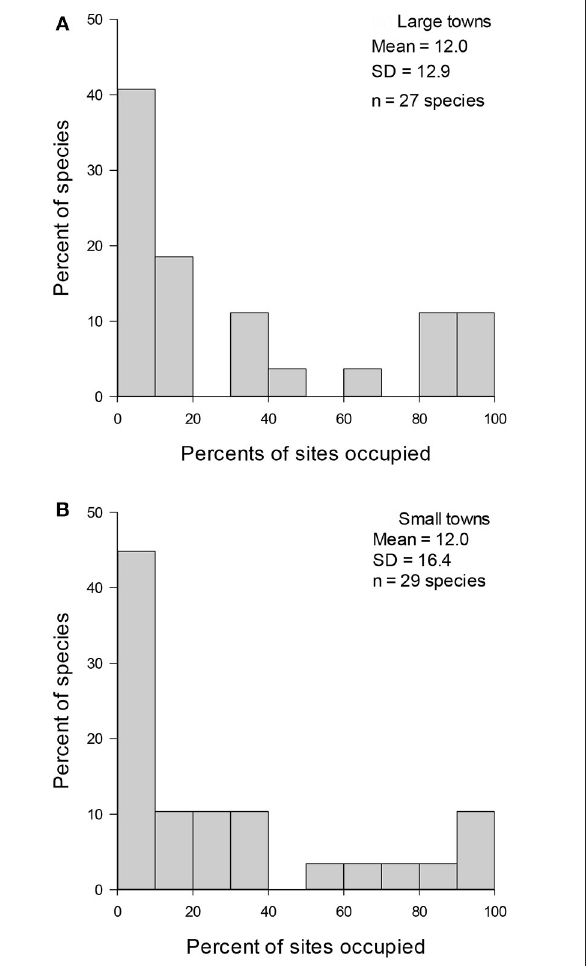
FIGURE 3 | Variation in urban wintering bird species relative occupancy frequency distributions in (A) large ( n = 12 towns) and (B) small towns ( n = 17 towns). Mean number of sites occupied and standard deviation (SD) of regional occupancy as well as the number of species ( n ) detected during three winters in